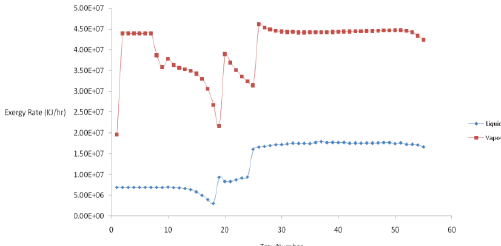
Figure 9. Profile of exergy rate versus tray number for Depropanizer of base case, 30 o C